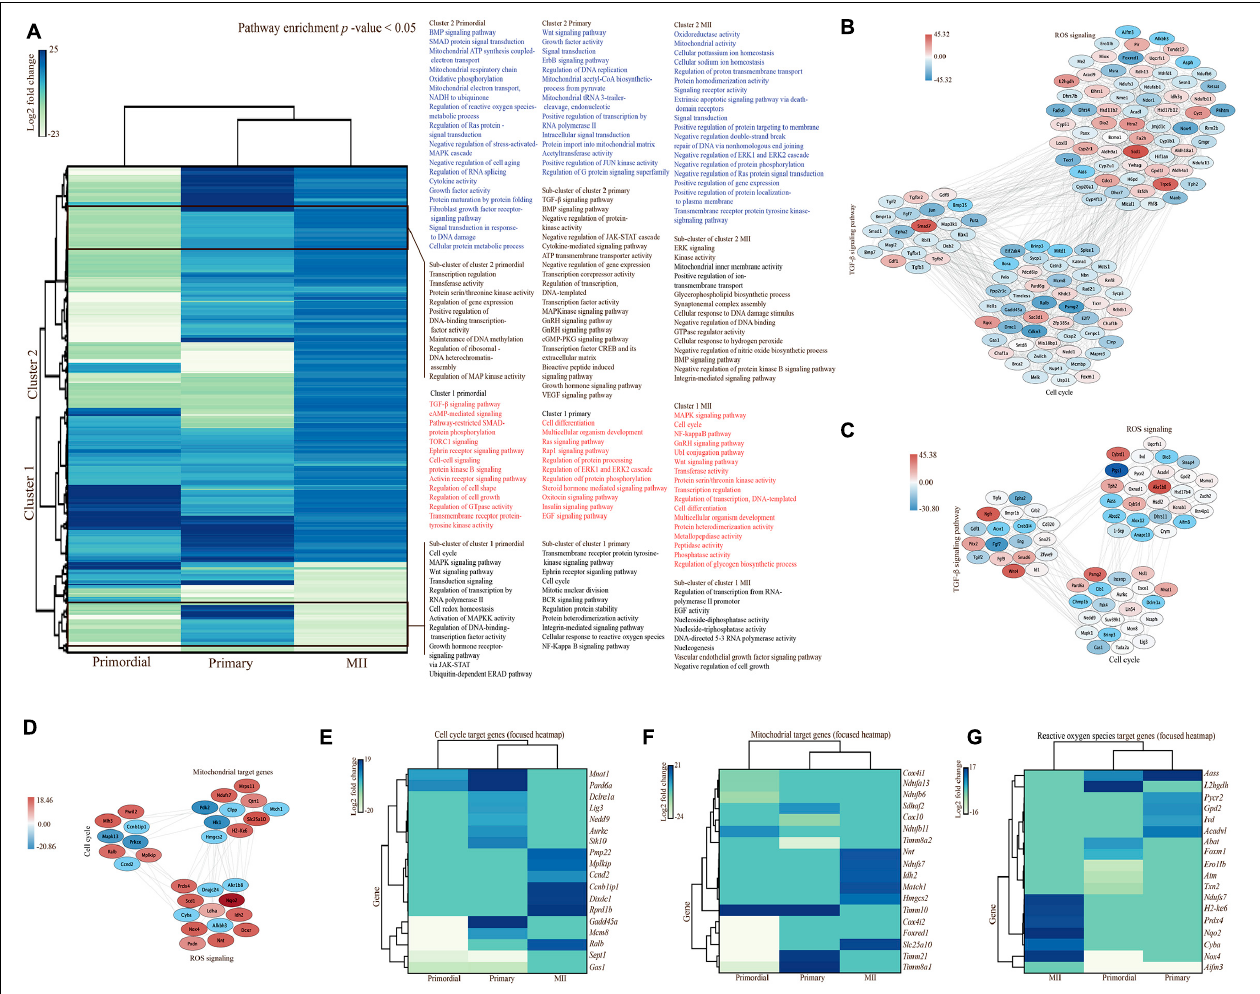
FIGURE 7 | Pathway enrichment analysis in oocytes. (A) Hierarchically clustered heatmap of the 302 selected significantly differentially expressed genes (SDEGs) in oocytes from primordial and primary follicles and MII oocytes in the in vitro group compared with the in vivo group. Pathway enrichment analysis was performed in each cluster of genes. Each subcluster of clusters is outlined, and the list of significantly enriched pathways is shown for each cluster and subcluster. Columns show different developmental stages of oocytes at the bottom. The color code based on log2 fold changes is shown as a scale (ranging from –23 to 25). (B–D) Interaction networks are shown for differentially expressed genes associated with the TGF- β signaling pathway, cell cycle, and ROS in oocytes from primordial (B) and primary follicles (C) and cell cycle-, ROS-, and mitochondria-related genes in MII oocytes (D) . (E–G) Focused heatmaps of the cell cycle (E) , mitochondrial function (F) , and ROS (G) of oocytes from primordial and primary follicles and MII oocytes in the in vitro group compared with the in vivo group. All involved genes are shown on the right-hand side, according to their colors on the left-hand side in each row of each heatmap. The color codes based on log2 fold changes are shown as a scale for each